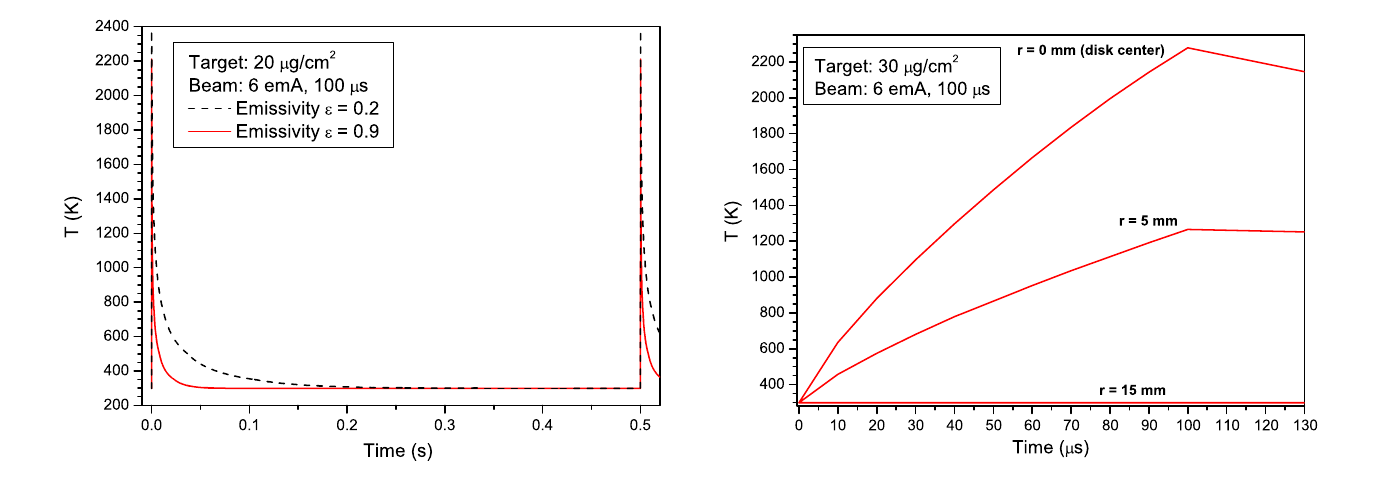
FIG. 6. Same as in Fig. 5, but for a longer time. FIG. 7. Same as in Fig. 3, but for foil thickness ¼ 30 μ g = cm 2